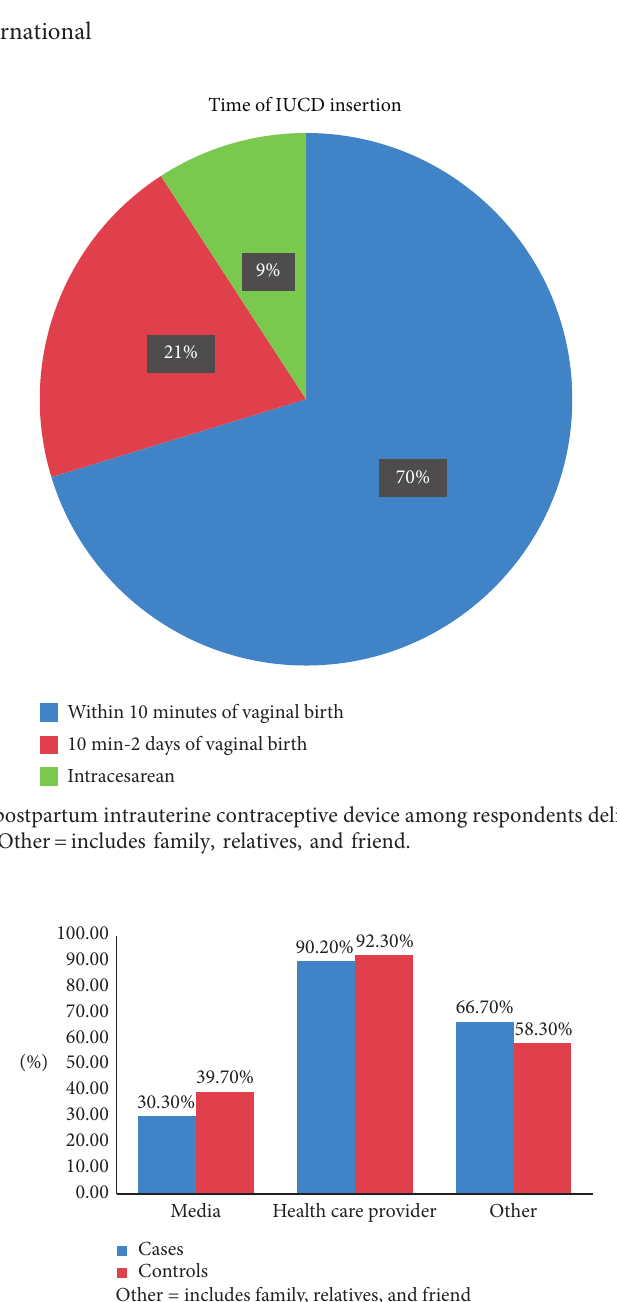
Figure 3: Distribution of information source about family planning among respondents delivering in public hospitals of South Gondar zone, Ethiopia, 2019 ( n � 132 cases and 156